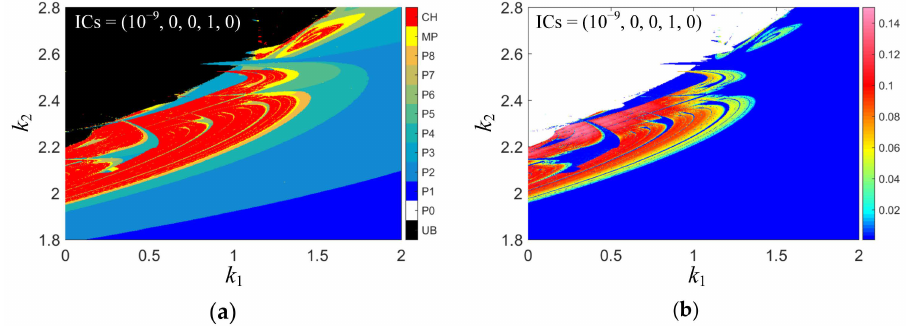
Figure 2. Two-parameter bifurcation diagram and dynamical map in the k 1 – k 2 plane for ICs = (10 − 9 , 0, 0, 1, 0): ( a ) bifurcation diagram, and ( b ) dynamical map.